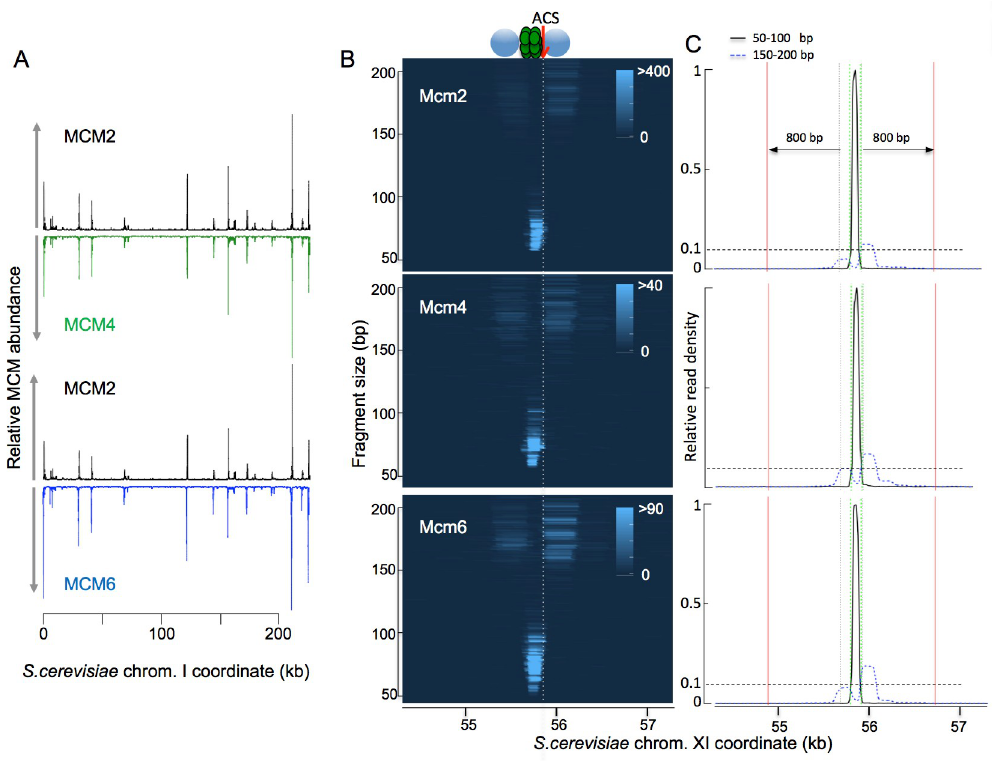
Fig 1. Tagging of MCM subunits with MNase in yeast reveals MCM helicase binding sites. (A) Plot of read depths across chromosome I, showing that binding sites for Mcm2 (black), Mcm4 (green) and Mcm6 (blue) are largely congruent. The y axes are scaled to the maxima of the read depths in the three samples, which are 38108, 2502 and 5482 for MCM2, MCM4 and MCM6, respectively, and include all the read sizes. (B) MCM binding sites represented as heat maps that are reminiscent of agarose gels. Chromosomal location is indicated on the X-axis, fragment size is indicated on the Y-axis and per-base pair read depths are indicated by color intensity. (The 3001 x 500 matrices of per-base pair read depths from which these heat maps were generated are available in the S1 Source Files associated with Fig 1B.) All three subunits generate similar footprints. Shown is ARS1103 on chromosome XI. (C) Quantitation of read depths in Fig 1B for fragments in the 50–100 bp (solid black) and 150–200 bp (dotted blue) ranges, which capture signal from MCM DHs and nucleosomes, respectively. The y axes are linear starting with 0 and are scaled such that the maximum read depth is 1.Vertical dotted green lines mark 60 bp from each side of the peak of MCM signal; vertical dotted black lines mark the origin boundaries, as defined in SGD; vertical solid red lines mark 800 bp on each side of the origin boundaries. We use the ratio of MCM signal within the green lines divided by MCM signal within the red lines as a metric for assessing the fraction of MCM signal that arises from a single DH, as described in the text. Source Files for generating the figures are provided as a